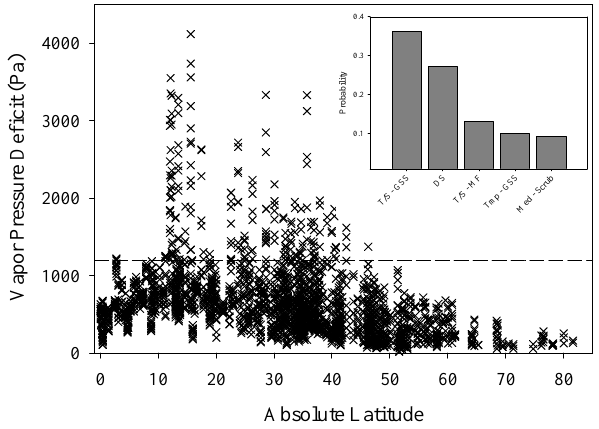
Absolute Latitude Figure 3. The global relationship of monthly vapor pressure deficit to absolute latitude for the 763 Fig. 3. The global relationship of monthly vapor pressure deficit IAEA dataset. The inset shows the probability distribution function for those ecosystems that 764 to absolute latitude for the IAEA dataset. The inset shows the experience monthly vapor pressure deficit greater than 1,200 Pa. Global ecosystem distribution 765 probability distribution function for those ecosystems that experi- was taken from the WWF terrestrial ecoregion dataset available at 766 http://www.worldwildlife.org/science/data/terreco.cfm. The ecosystems include tropical and 767 ence monthly vapor pressure deficit greater than 1200Pa. Global subtropical grassland, savanna and shrubland (T/S-GSS), desert scrub (DS), tropical and 768 ecosystem distribution was taken from the WWF terrestrial ecore- subtropical moist forest (T/S-MF), temperate grassland, savanna and shrubland (Tmp-GSS), and 769 gion dataset available at http://www.worldwildlife.org/science/data/ Mediterranean scrub (Med-Scrub). 770 terreco.cfm. The ecosystems include tropical and subtropical grass- land, savanna and shrubland (T/S-GSS), desert scrub (DS), tropi- cal and subtropical moist forest (T/S-MF), temperate grassland, sa- vanna and shrubland (Tmp-GSS), and Mediterranean scrub (Med-